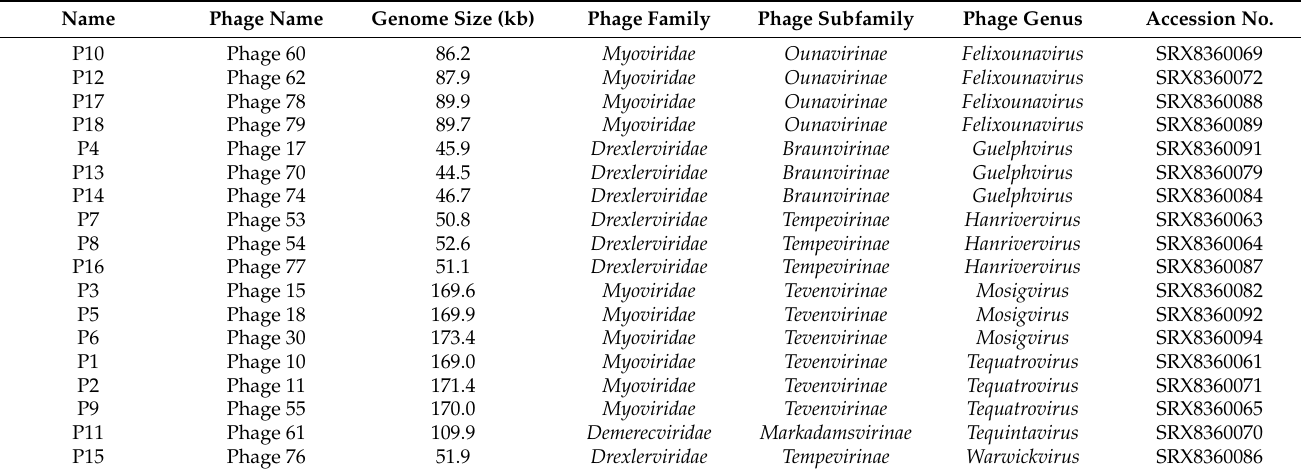
Table 2. Coliphage characteristics.